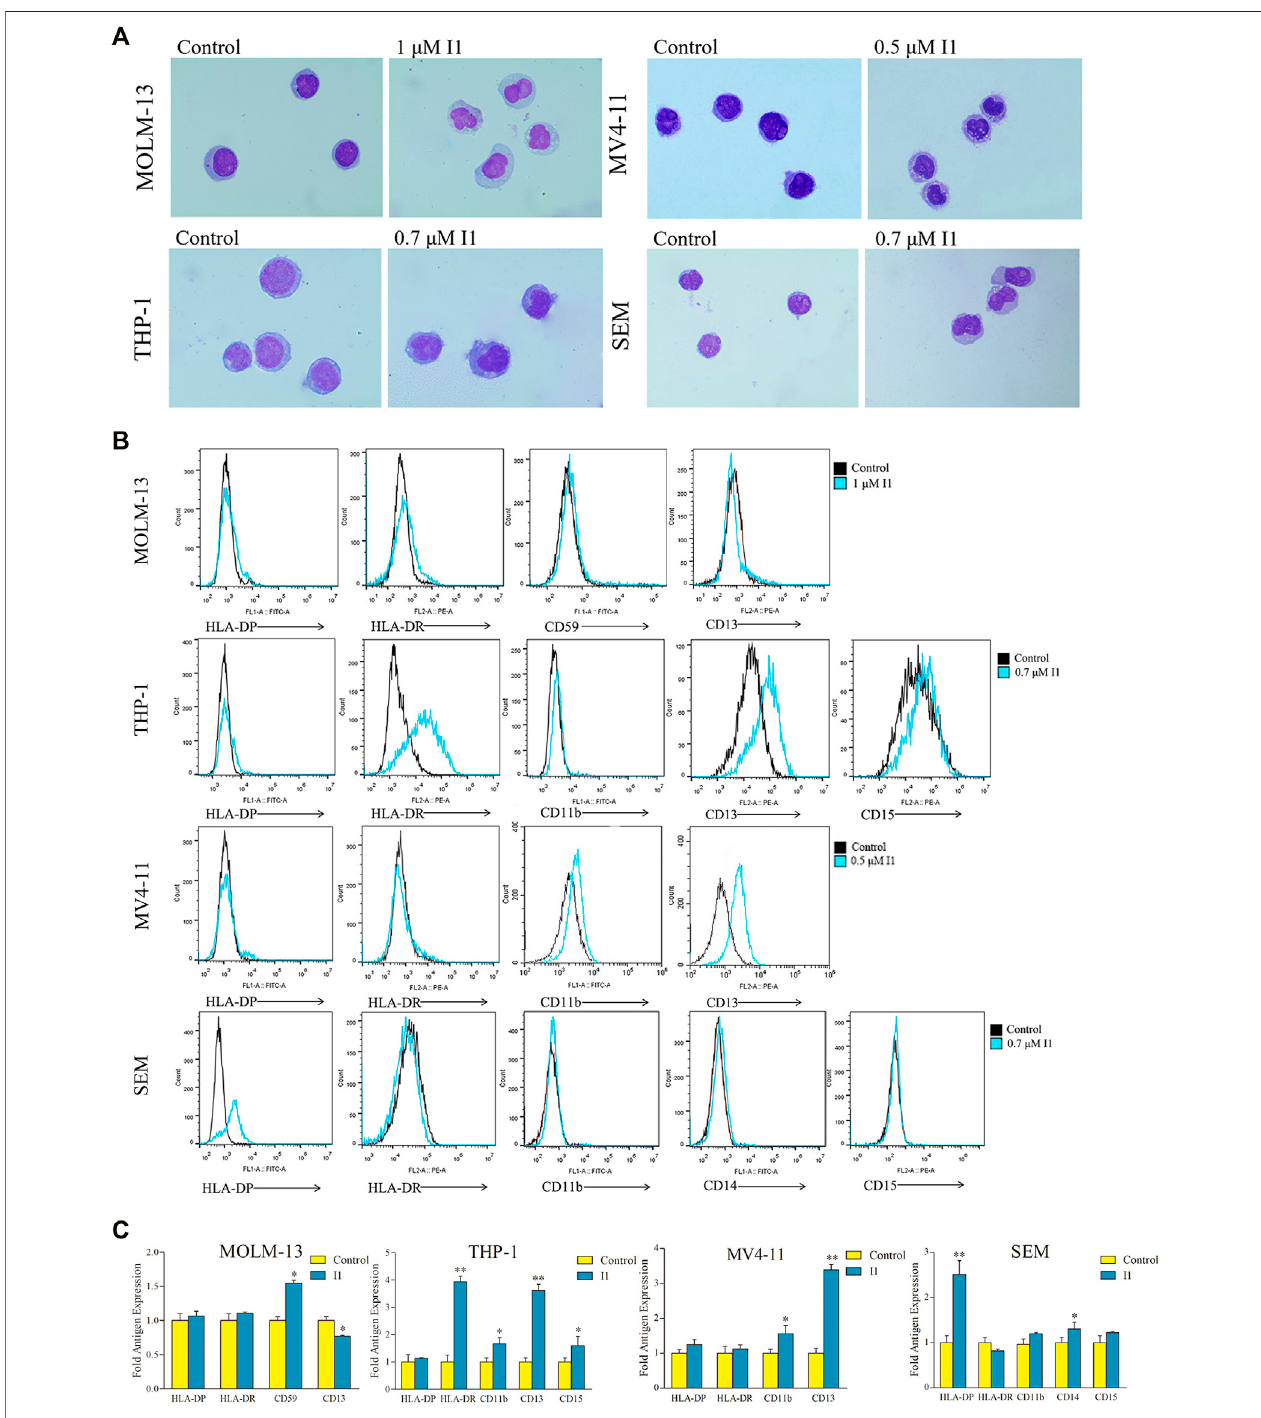
FIGURE5 | I1induces differentiation ofMOLM-13, THP-1, MV4-11 and SEM cells. (A) The morphology ofWright-Giemsa stained cells examined by oil immersion lens (×1,000). (B) The expression of different antigens of cells measured by fl ow cytometry. (C) Graph bars show the mean fl uorescence intensity (MFI) of antigens. MOLM-13,THP-1,MV4-11andSEMcellswereincubatedwith1,0.7,0.5or0.7 μ MI1,repectivelyfor72 h(* p < 0.05,** p < 0.01).The fi guresarerepresentativeofthree independent experiments.